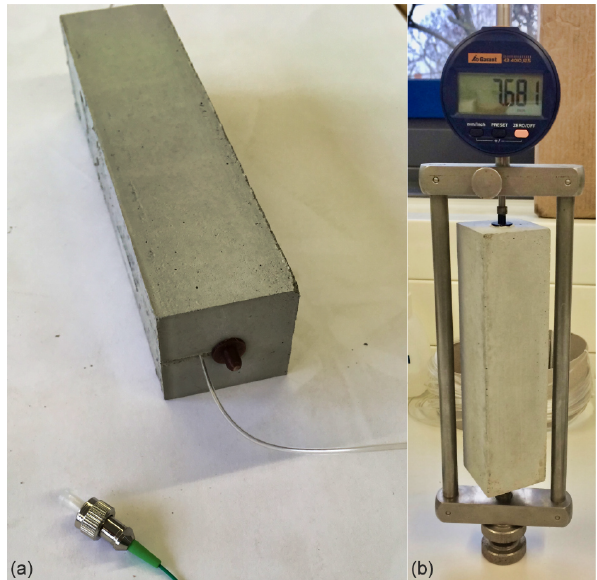
Figure 5. (a) Test specimen with sensor fiber and measuring pin;